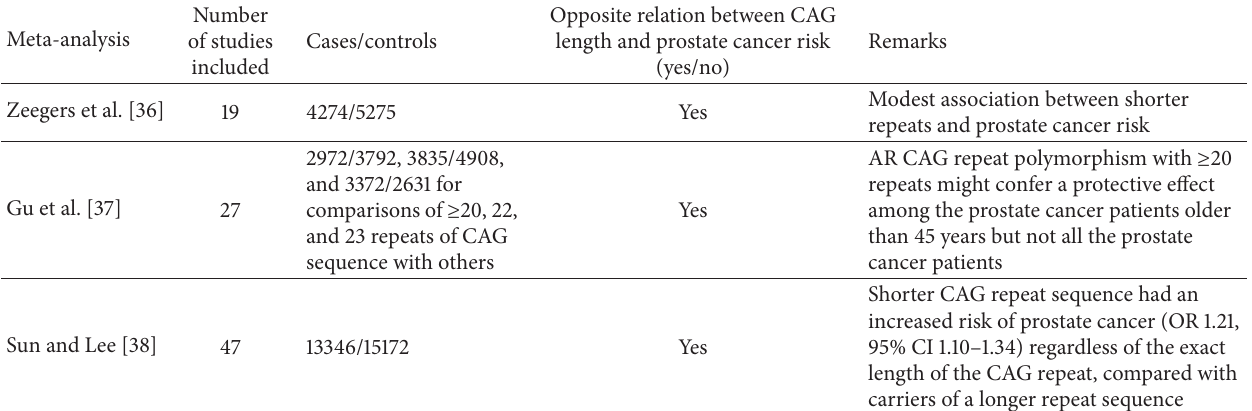
Table 1: Summary of meta-analysis results regarding the association between androgen receptor CAG repeat and prostate